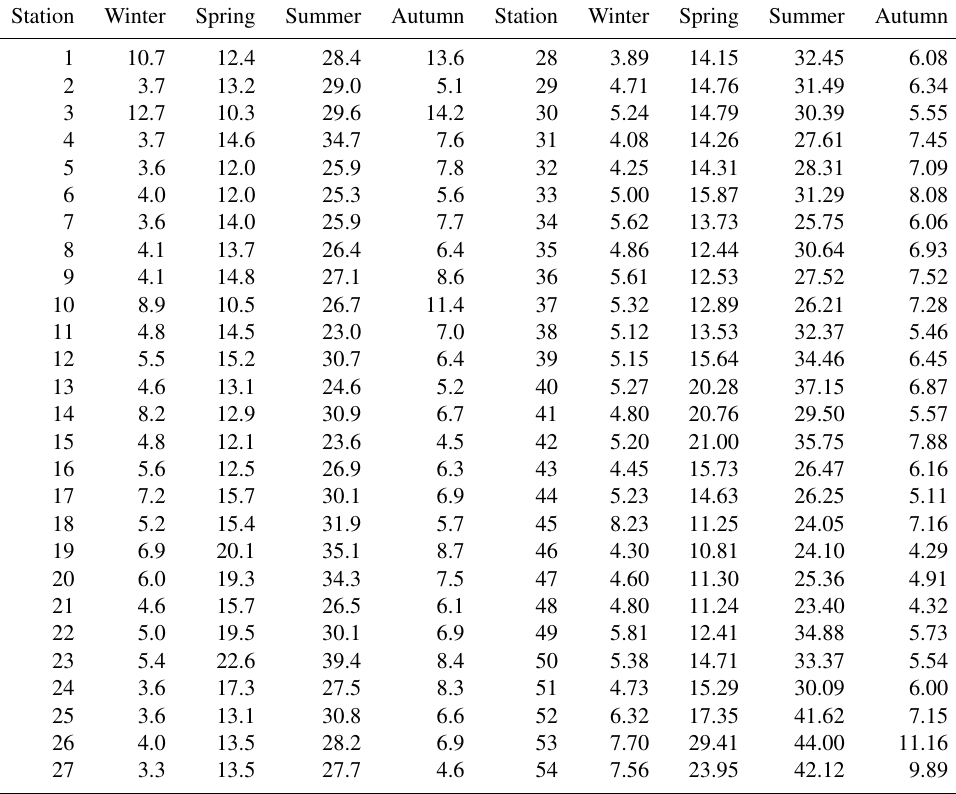
Table 2. Confidence interval for mean precipitation difference of the observed and simulated data for seasonal data. Station Winter